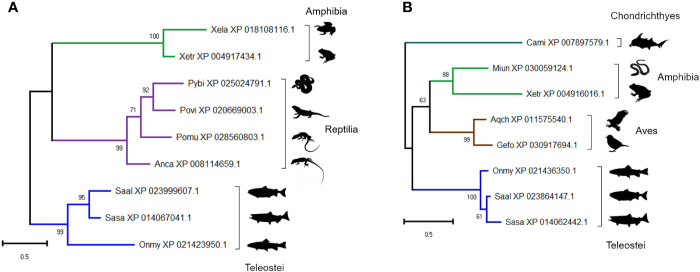
Maximum likelihood consensus trees for two trout proteins annotated as ‘uncharacterized’: (A) XP_021436350 and (B) XP_021423950, including putative orthologues in other taxa. The trees were generated using the best fitting amino acid substitution model and includes branch support values from 1,000 ultrafast bootstrap replicates. Species abbreviations: Anca, Anolis carolinensis (green anole); Aqch, Aquila chrysaetos (Golden eagle); Cami, Callorhinchus milii (elephant shark); Gefo, Geospiza fortis (medium ground finch); Miun, Microcaecilia unicolor (caecilian spp.); Onmy, Oncorhynchus mykiss (rainbow trout); Pomu, podarcis muralis (common wall lizard); Povi, Pogona vitticeps (bearded dragon); Pybi, Python bivittatus (Burmese python); Saal, Salvelinus alpinus (Arctic charr); Sasa, Salmo salar (Atlantic salmon); Xela, Xenopus laevis (African clawed frog); Xetr, Xenopus tropicalis (Western clawed frog).